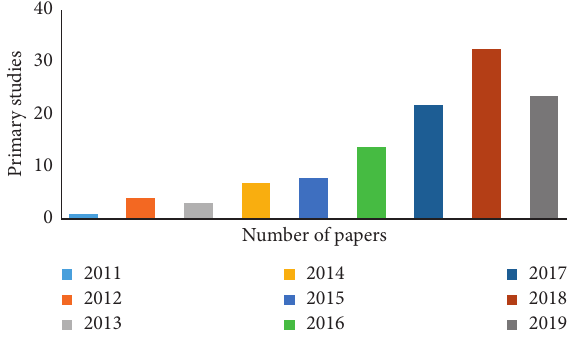
Figure 4: Primary studies reported annually. Table 2: Description of m-Health devices.